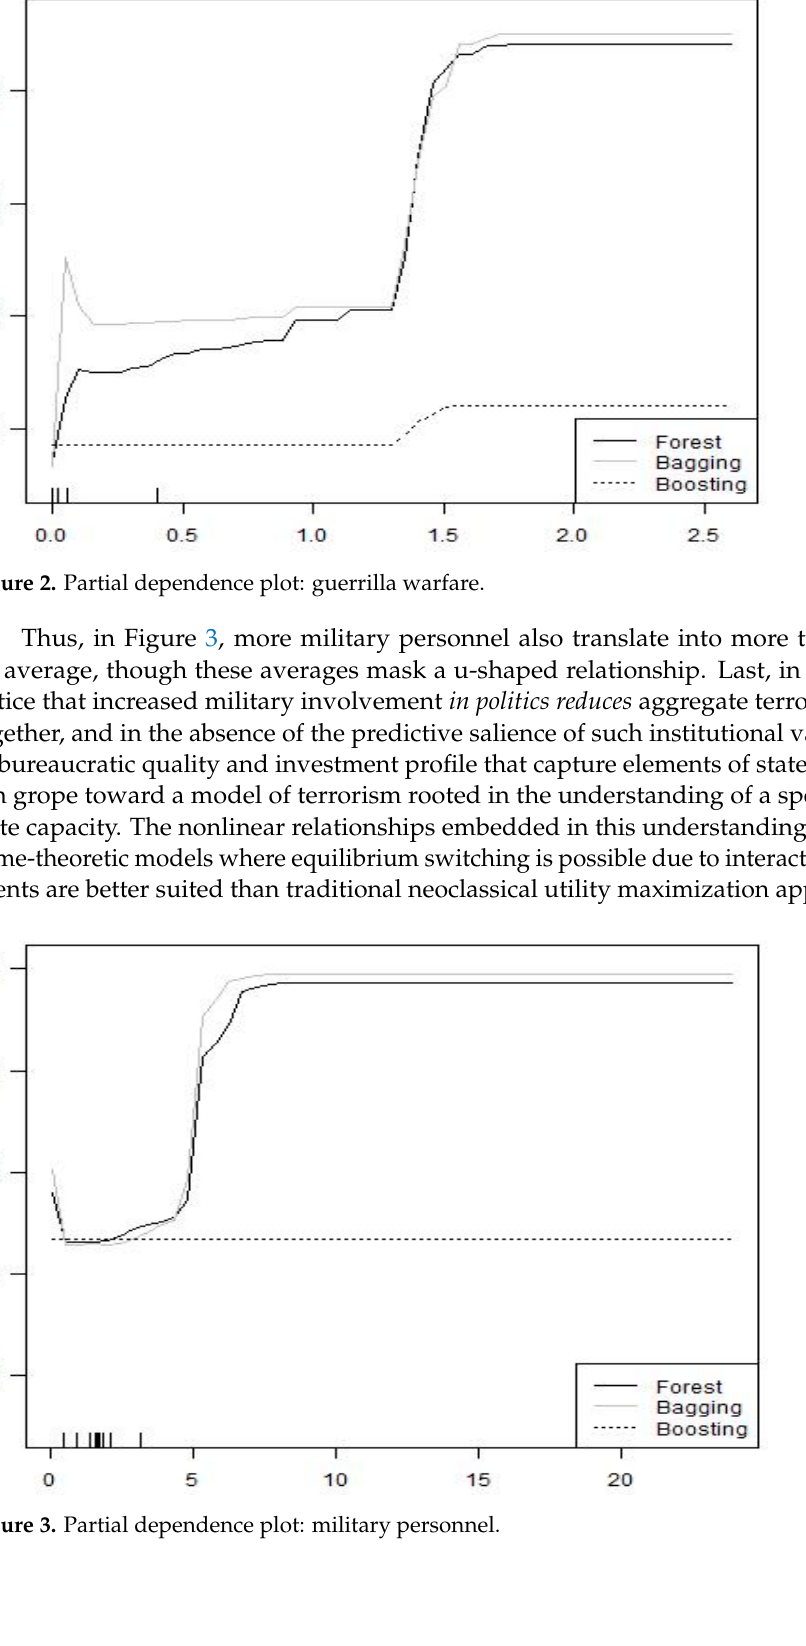
Figure 4. Partial dependence plot: military in politics. State capacity (or the lack thereof) is a reasonably standard explanation for conflict [34]. The theoretical basis for an empirical understanding of this relationship lies in three concepts: military capacity, administrative quality, and institutional coherence. [35] suggests that military personnel and expenditures, bureaucratic quality measures, and popular institutional measures such as polity or those reported by ICRG have construct and theoretical validity as a measure of the three elements of state capacity. We have all these variables as part of our predictive algorithm. Nevertheless, of these three, it appears that military capacity is most salient for understanding terrorism. Thus, our algorithm has been pretty specific about what kind of theoretical models are more likely explanations for terrorist attacks. This suggests that models better understand why terrorism happens [13]. The how matters as well. There is a clear equilibrium switch in the number of terrorist attacks as guerilla war- fare intensifies. However, there is an optimum level of intensity beyond which the number of terrorist attacks is stable. Again, this is the result suggested by game-theoretic models